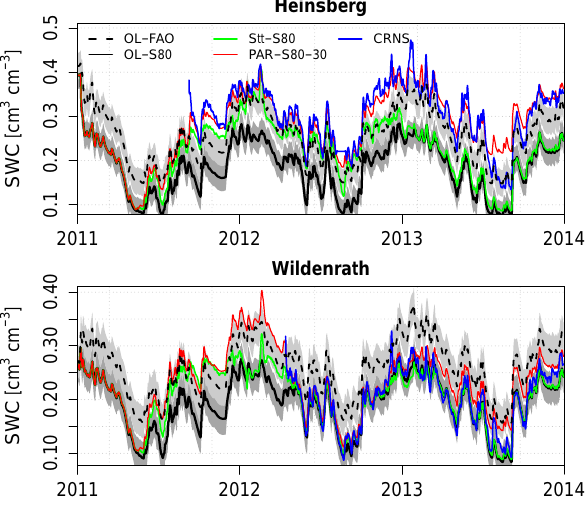
Figure 3. Temporal evolution of simulated soil water con- tent (SWC) retrievals, calculated with open loop (OL- ∗ ), data as- similation with state update only (Stt-S80), and data assimila- tion including parameter updating (PAR-S80-30), together with the CRNS SWC retrieval at the sites Heinsberg and Wildenrath for the data assimilation period 2011 and 2012 and the evaluation pe- riod 2013. Simulated SWC was vertically weighted to obtain the appropriate SWC corresponding to the CRNS SWC retrieval.